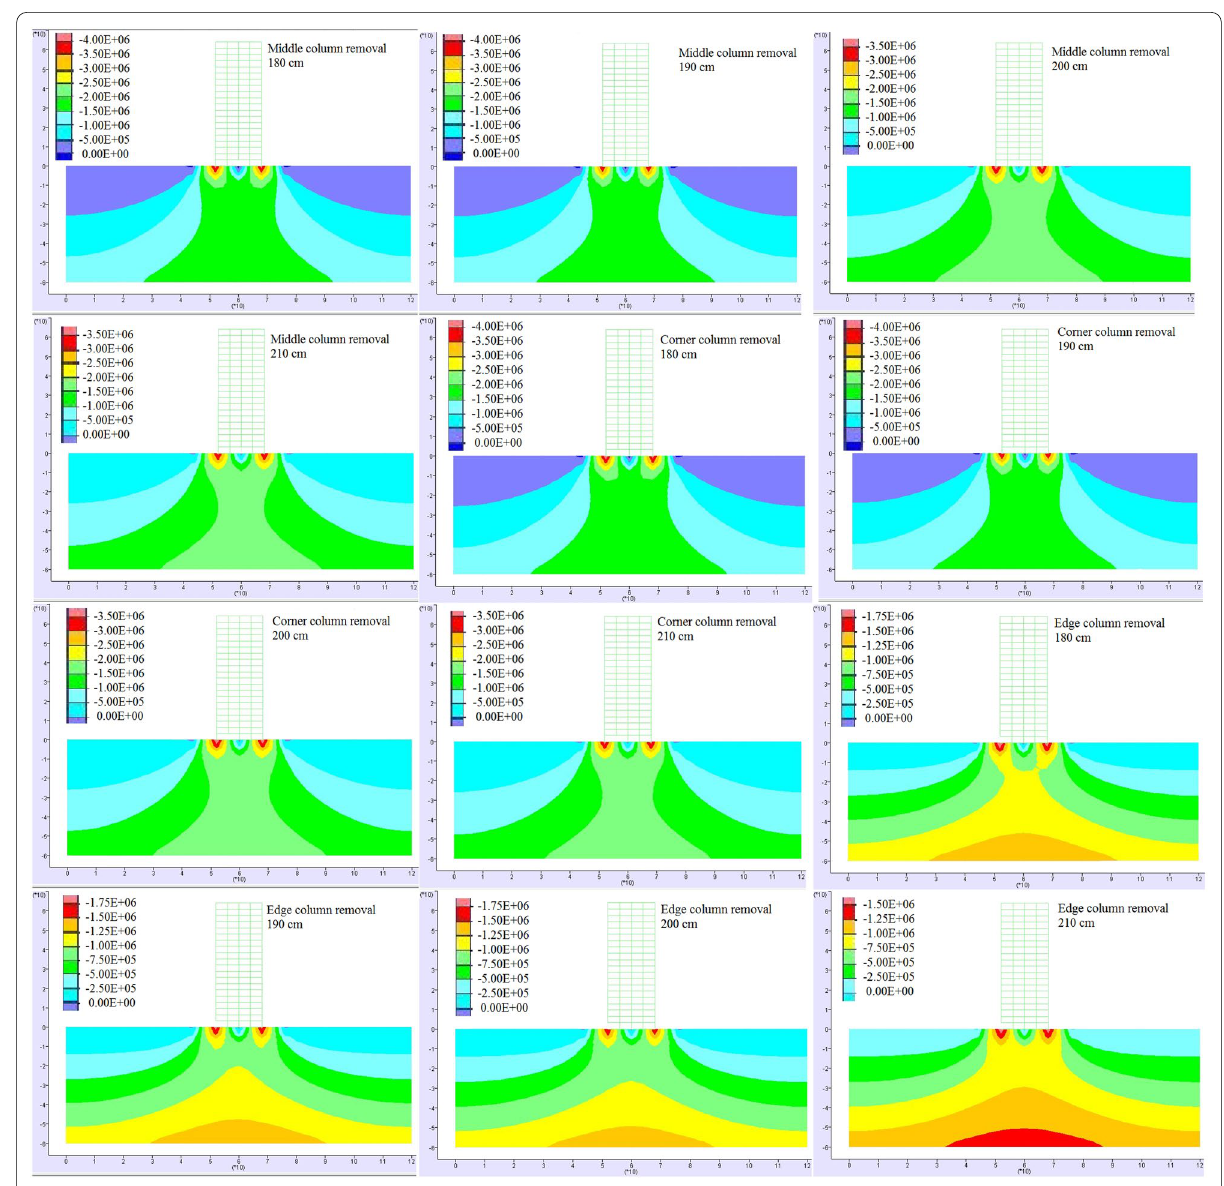
Fig. 10 SYY contours of the frames with column removal with different thicknesses of